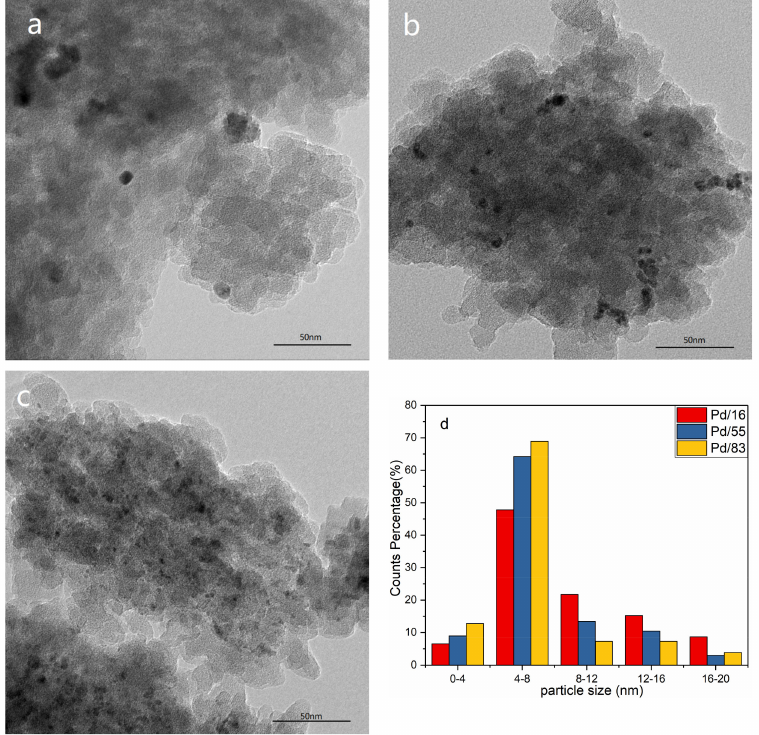
Figure 3. HRTEM figures of each sample (( a ): Pd/16; ( b ): Pd/55; ( c ): Pd/83) and size distribution of PdO ( d